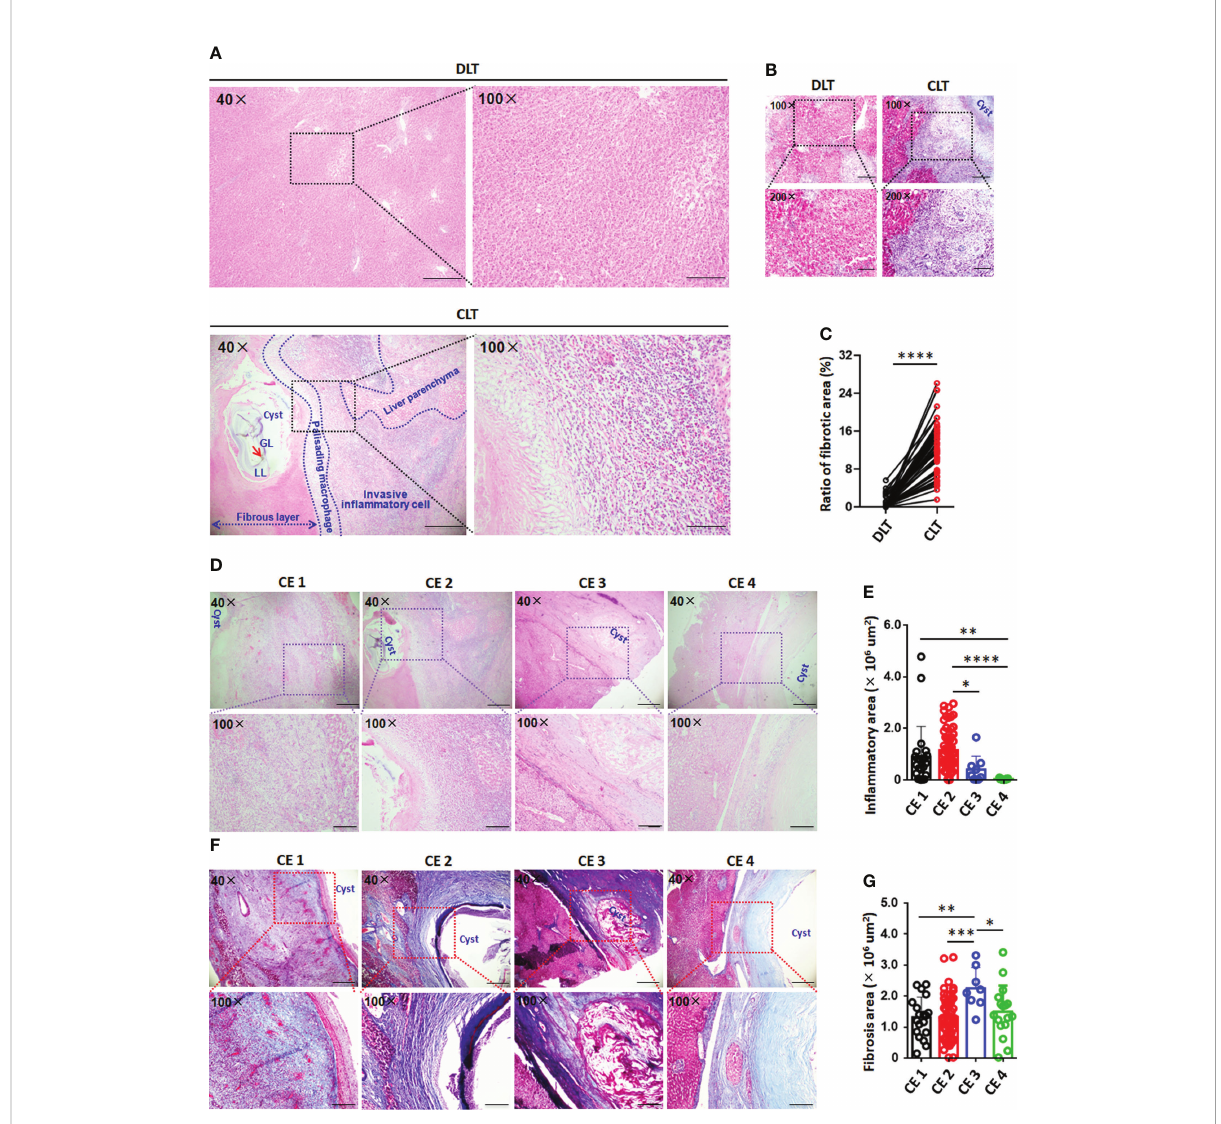
FIGURE 1 Histopathology and immune microenvironment of the liver in CE patients with hydatid cysts. (A) Representative hematoxylin and eosin (H&E) staining (left panel 40×, enlarged 100× on the right panel) of paired liver section from CE patients. Close liver tissue showed the cysts, fi brous layer, invasive in fl ammatory cell regions and liver parenchyma, delimited with the dotted line. (B) Representative liver fi brosis (upper panel 100×, enlarged 200× on the lower panel) as determined by Masson staining on paired liver tissue samples close to lesion (CLT) versus those distant from lesion (DLT) from CE patients. (C) The fi brosis area of liver section was quanti fi ed using cellSens Diemension software, the ratio of fi brosis area and total area (%) was counted from (B) (n=48). (D) Representative in fl ammatory cell in fi ltration (upper panel 40×, enlarged 100× on the lower panel) in liver section from CE patients at different stages. (E) The in fl ammatory cell in fi ltration area of liver section was quanti fi ed using cellSens Diemension software, the in fl ammatory area size ( m m 2 ) was counted from (D) (n=107). (F) Representative liver fi brosis (upper panel 40×, enlarged 100× on the lower panel) in liver section from CE patients at different stages. (G) The fi brosis area of liver section was quanti fi ed using cellSens Diemension software, the fi brosis area size ( m m 2 ) was counted from (F) (n=103). Data are expressed as mean ± SD, analyzed by Student ’ s t tests. * P < 0.05, ** P < 0.01, *** P < 0.001, **** P <